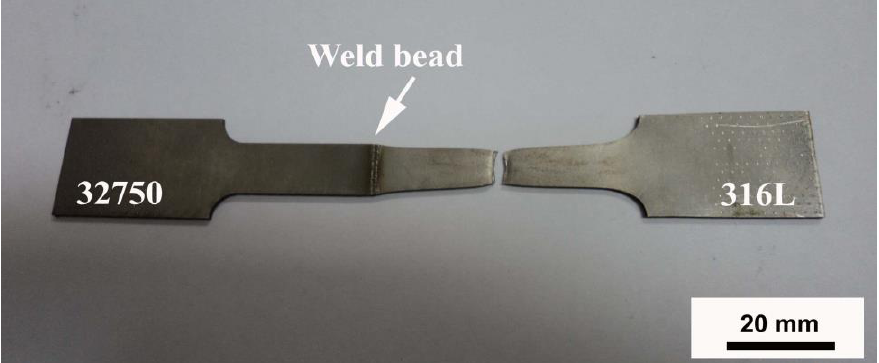
Figure 7. Tensile test specimen D3.